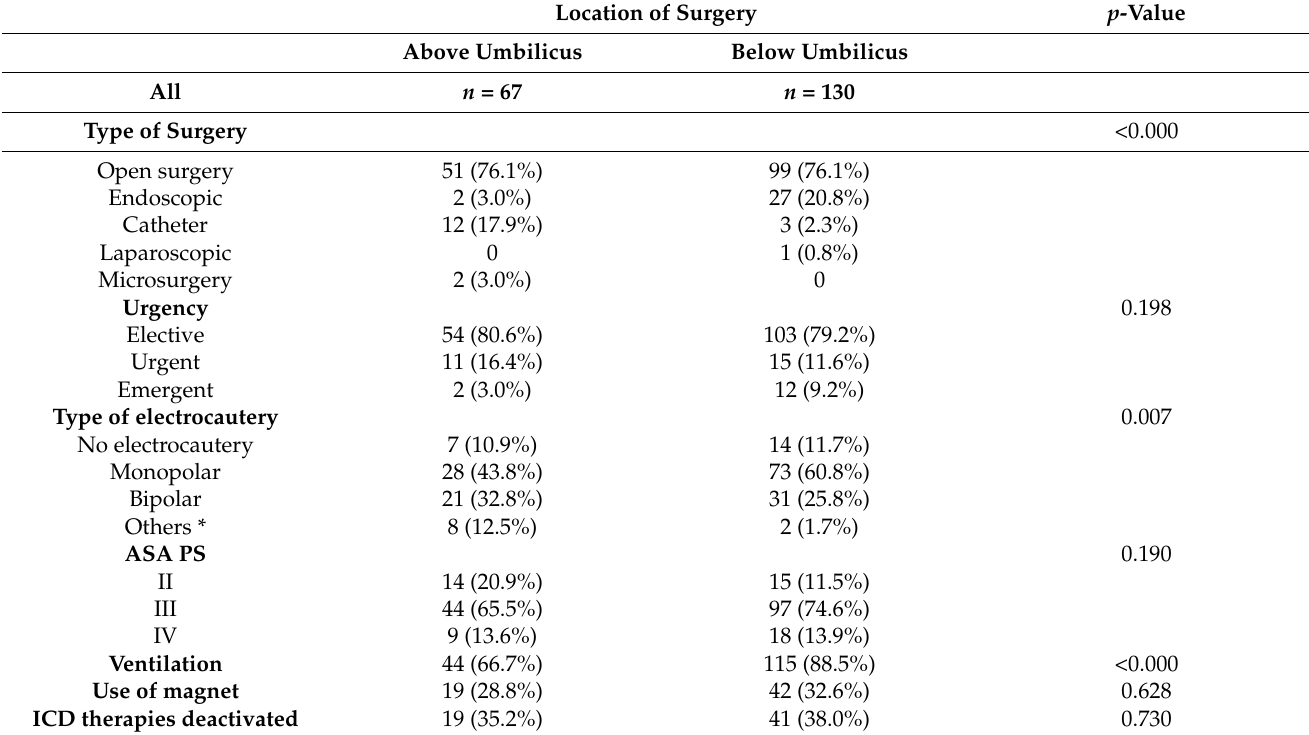
Table 5. Anesthesiologic information of interventions above and below